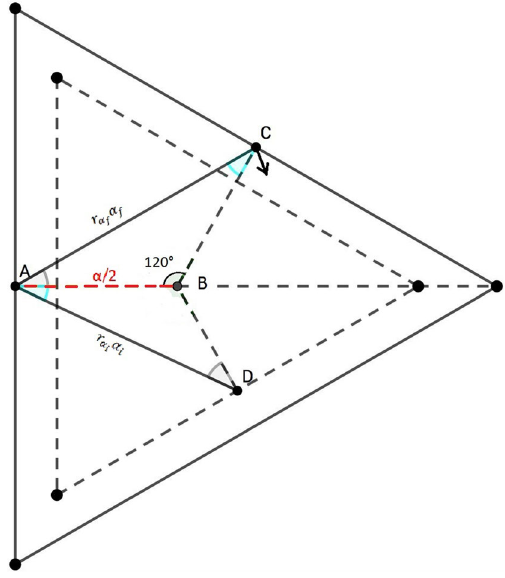
Fig. 5 Geometric relations between two successive bounces